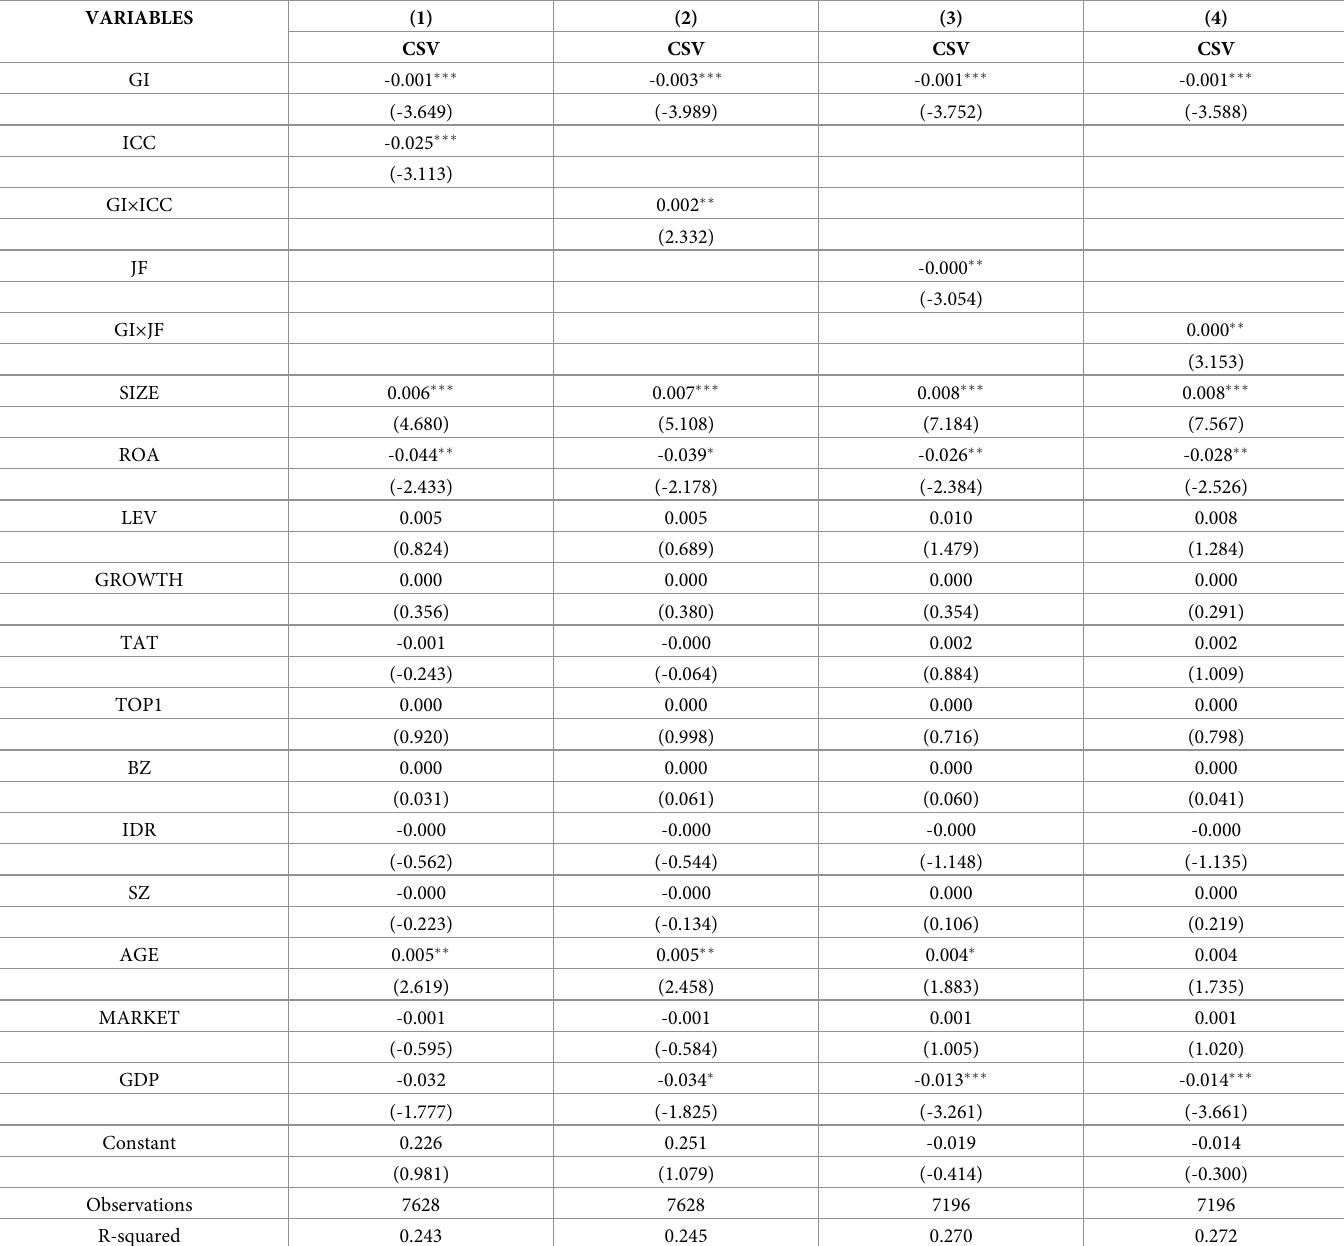
Table 9. Further analysis